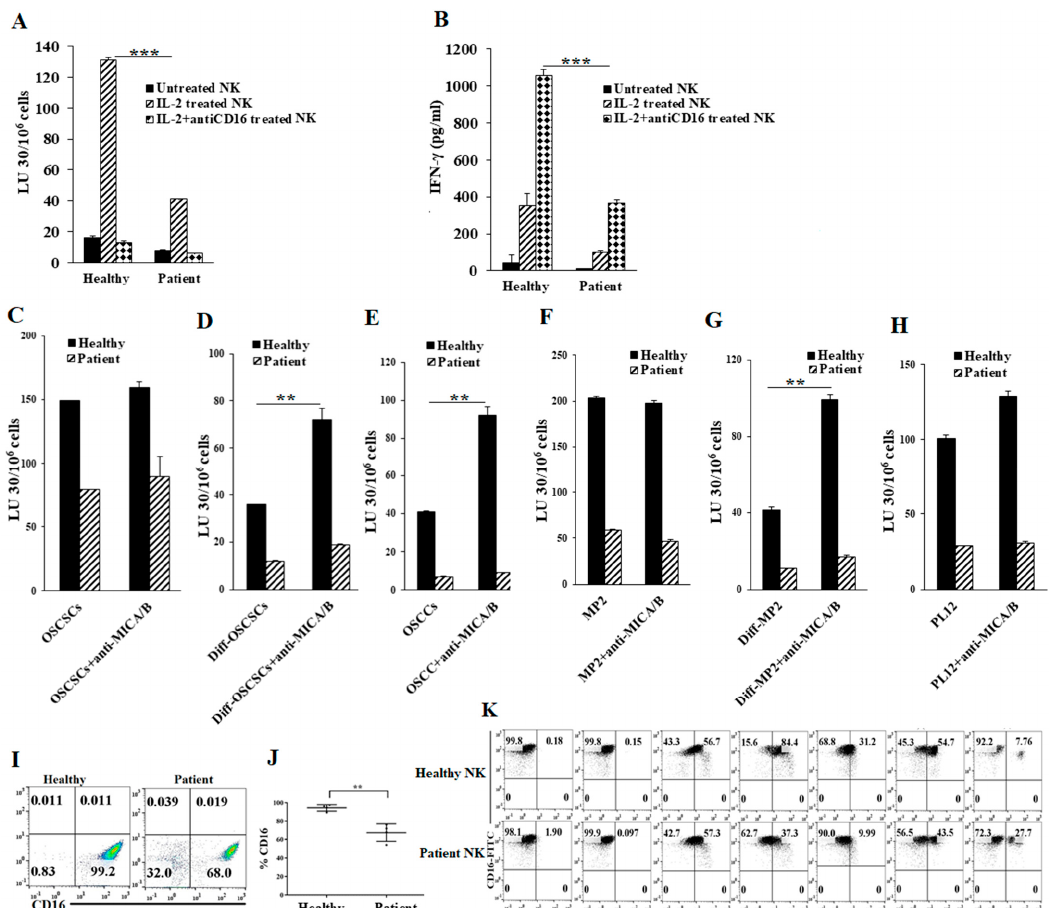
Figure 1. Cancer patients’ natural killer (NK) cells exhibit lower functional activity and NK cell-mediated antibody-dependent cell cytotoxicity (ADCC) when compared to healthy individuals’ NK cells. Purified NK cells (1 × 10 6 cells/mL) from healthy individuals and pancreatic cancer patients were left untreated, treated with interleukin-2 (IL-2) (1000 U/mL), or treated with a combination of IL-2 (1000 U/mL) and anti-CD16 mAb (3 µg/mL) for 18 h and were added to 51 Cr-labeled oral stem-like/poorly-differentiated oral squamous cancer stem cells (OSCSCs) at various effector-to-target ratios. NK cell-mediated cytotoxicity was measured using a standard 4-h 51 Cr release assay against OSCSCs. The lytic units (LU) 30/10 6 cells were determined using the inverse number of NK cells required to lyse 30% of target cells × 100 ( A ) *** ( p value < 0.001). NK cells were isolated and prepared as described in Figure 1A for 18 h before the supernatants were harvested and the levels of IFN- γ secretion were determined using single ELISA ( B ) *** ( p value < 0.001). One of 20 experiments is shown in Figure 1A,B. Purified NK cells (1 × 10 6 cells/mL) from healthy individuals and cancer patients were treated with IL-2 (1000 U/mL) for 18 h and were used as effectors in 51 Cr release assay. OSCSCs and Mia PaCa-2 (MP2) tumors were differentiated as described in the Materials and Methods. OSCSCs ( C ), NK cell-differentiated OSCSCs ( D ) , oral squamous carcinoma cells (OSCCs) ( E ), MP2 ( F ), NK cell-differentiated MP2 ( G ) , and PL12 cells ( H ) were labeled with 51 Cr for an hour, after which cells were washed to remove unbound 51 Cr. Then, 51 Cr-labeled tumor cells were left untreated or treated with anti-major histocompatibility complex-class I chain related proteins A and B (MICA/B) monoclonal antibodies (mAbs) (5 µ g/mL) for 30 min. The unbounded antibodies were washed away, and the cytotoxicity against the tumor cells was determined using a standard 4-h 51 Cr release assay. LU 30/10 6 cells were determined as described in Materials and Methods ( C–H ) ** ( p value 0.001–0.01). The surface expression levels of CD16 of freshly purified NK cells from healthy individuals and cancer patients were analyzed using flow cytometry. IgG2 isotype antibodies were used as controls ( n = 4) ( I,J ) ** ( p value 0.001–0.01). Freshly purified NK cells from healthy individuals and cancer patients were analyzed for the surface expression levels of CD16, Nkp30, Nkp44, Nkp46, CD94, NKG2D, KIR2, and KIR3 using flow cytometry. IgG2 isotype antibodies were used as controls ( K ). One of eight representative experiments is shown in Figure